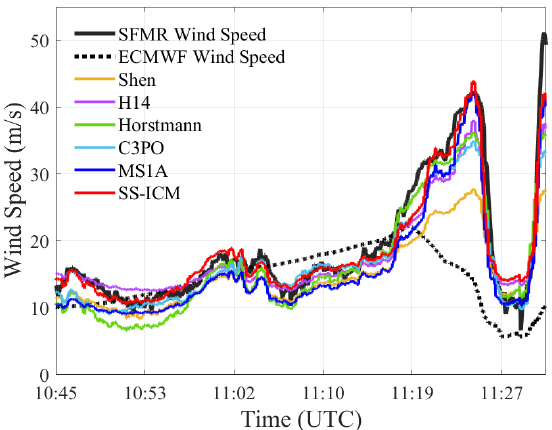
Figure 14. The comparison between the retrieved wind speeds and the wind speed from SFMR.